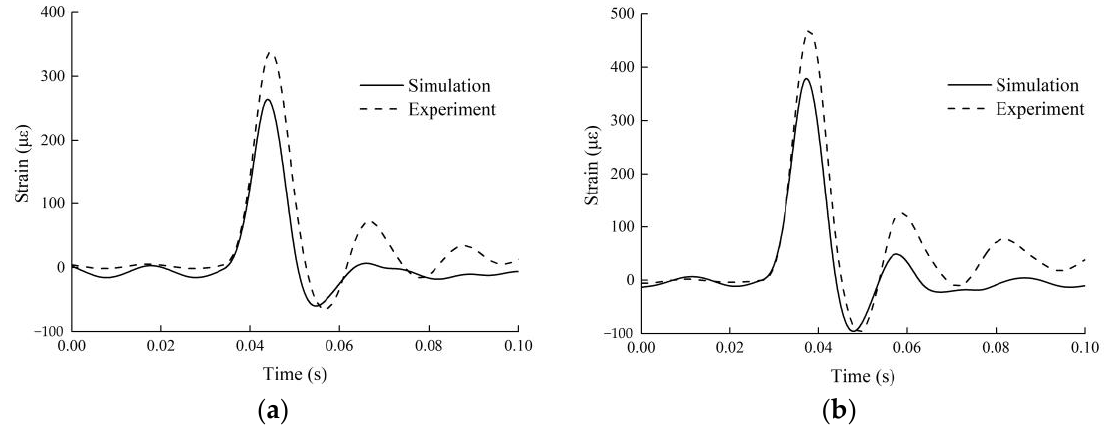
Figure 14. Strain comparison of rebar in C_1: ( a ) drop height = 30 cm and ( b ) drop height = 80 cm.